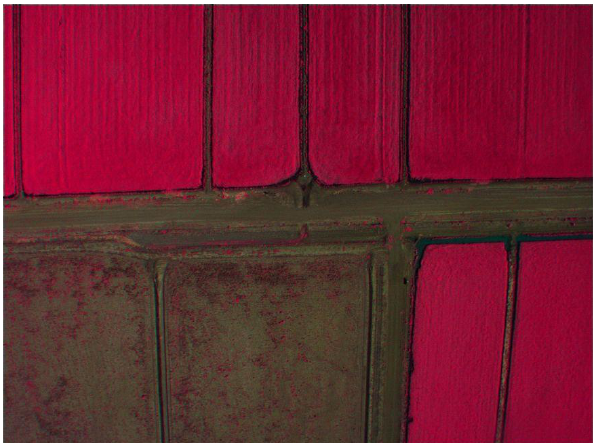
Figure 6. Multi-spectral image of rice fields taken with SUSI 62 (NSW